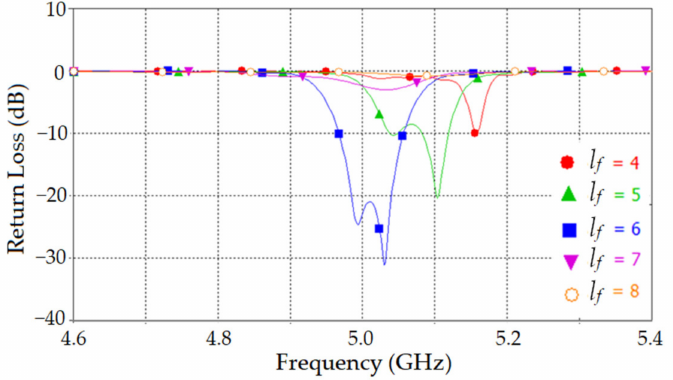
Figure 9. Simulated return loss for different values of ‘ l f